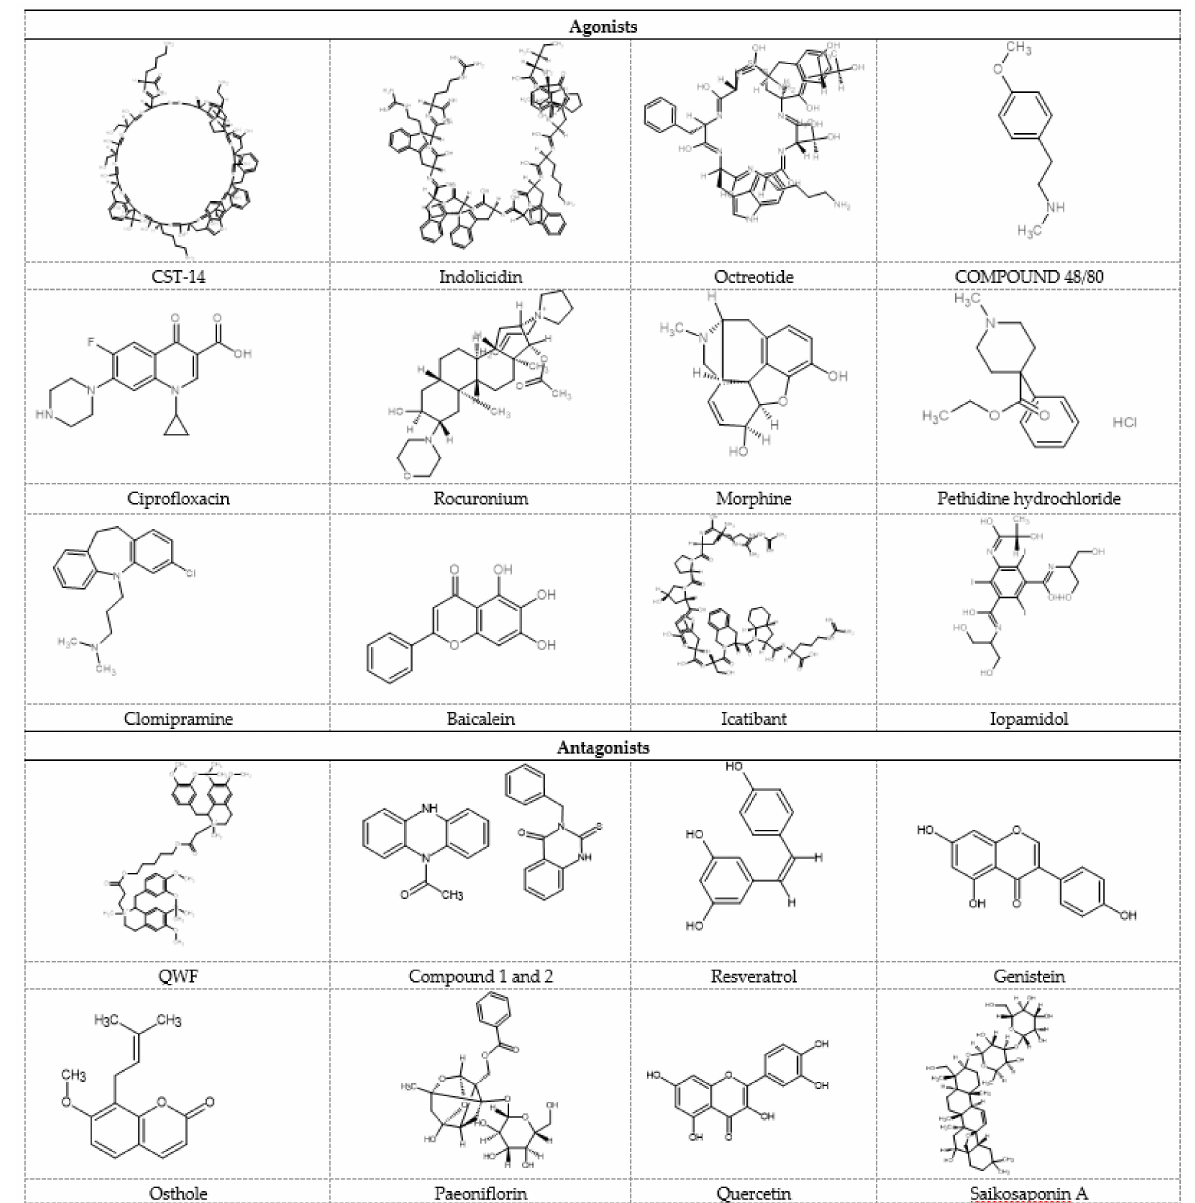
Figure 3. 2D chemical structure of some MRGPRX2 agonists and antagonists. Epithelium and neutrophil-derived HDPs (hBDs and LL-37) have recently been re- ported to activate human MCs via MRGPRX2 [50,102,103]. This activation leads to MC degranulation but also the release of significantly less pro-inflammatory cytokines [56]. However, keratinocytes show a different response against LL-37 challenge, possibly via the activation of MRGPRX3/4. This activation leads to degranulation with a very high generation of pro-inflammatory cytokines and promotes wound healing [79,97]. Thus, the interaction between keratinocytes and mast cells via MRGPRX3/4 and MRGPRX2, respectively, has demonstrated a potential pathway involved in cutaneous host defense and wound healing. In addition, SP, a known endogenous ligand of MRGPRX2, has been shown to play a role in neurogenic inflammation and pain associated with wound healing by recruiting innate immune cells to the injury site [74]. In the following section, we have summarized the MRGPRX2 agonists into different groups according to their chemical nature such as peptides and non-peptides (drugs and natural compounds) (Table